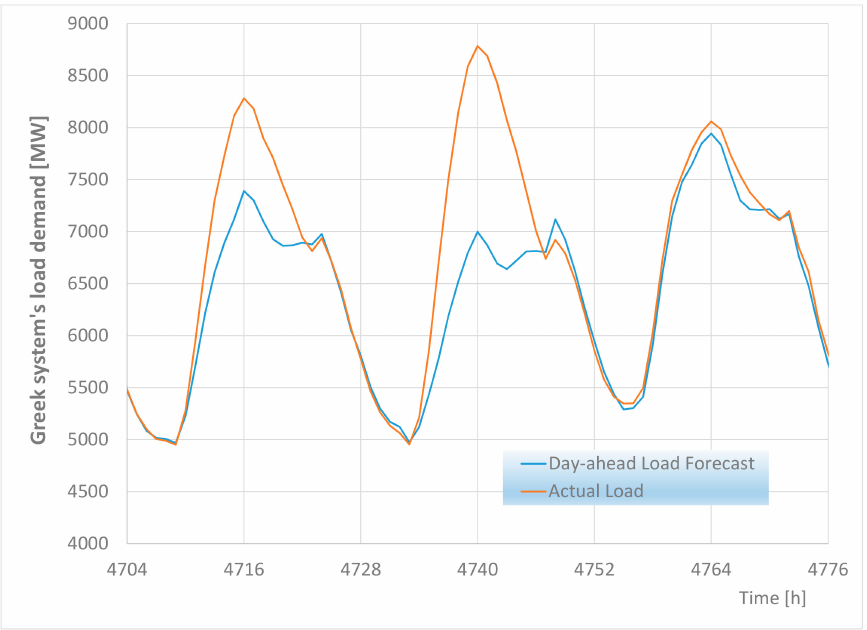
Figure 7. Prediction failure for the period during the weekend 16–17 July with high ambient temper- atures [35]. Maximum relative error is −